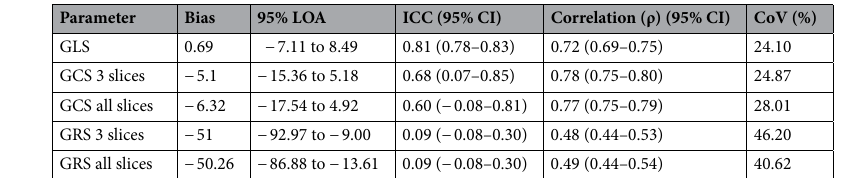
Table 3. Agreement between manual and automated strain analyses; GLS, GCS 3 slices, GCS all slices, GRS 3 slices and GRS all slices. Automated GCS and GRS all slices were compared to the manual method of obtaining the average of 3 slices. Correlation is represented by Spearman’s ρ. CoV indicates coefficient of variation; GCS, global circumferential strain; GLS, global longitudinal strain; GRS, global radial strain; ICC, intraclass correlation coefficient; LOA limits of